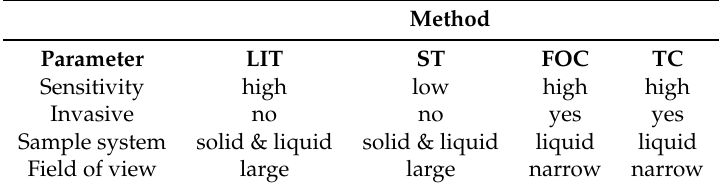
Table 1. Overview of common methods used for the characterisation of nanomaterial heat